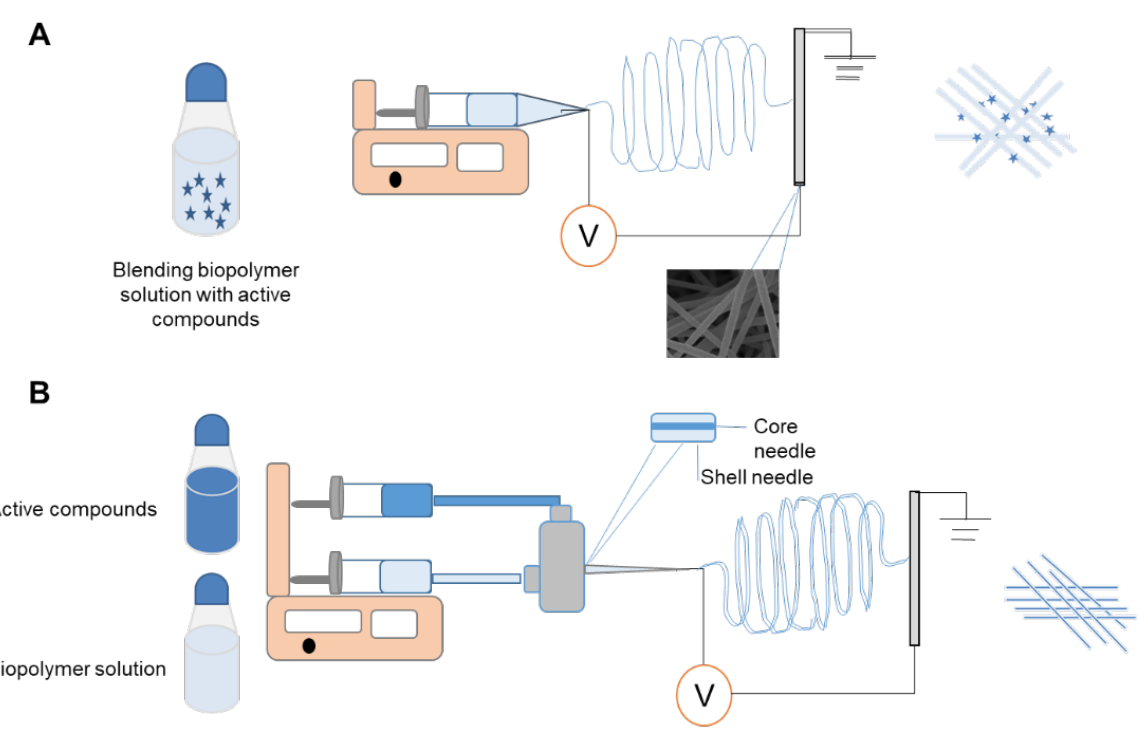
Figure 1. Schematic illustration of different electrospinning approaches and resulting fibres. ( A ) Uniaxial, ( B ) coaxial.